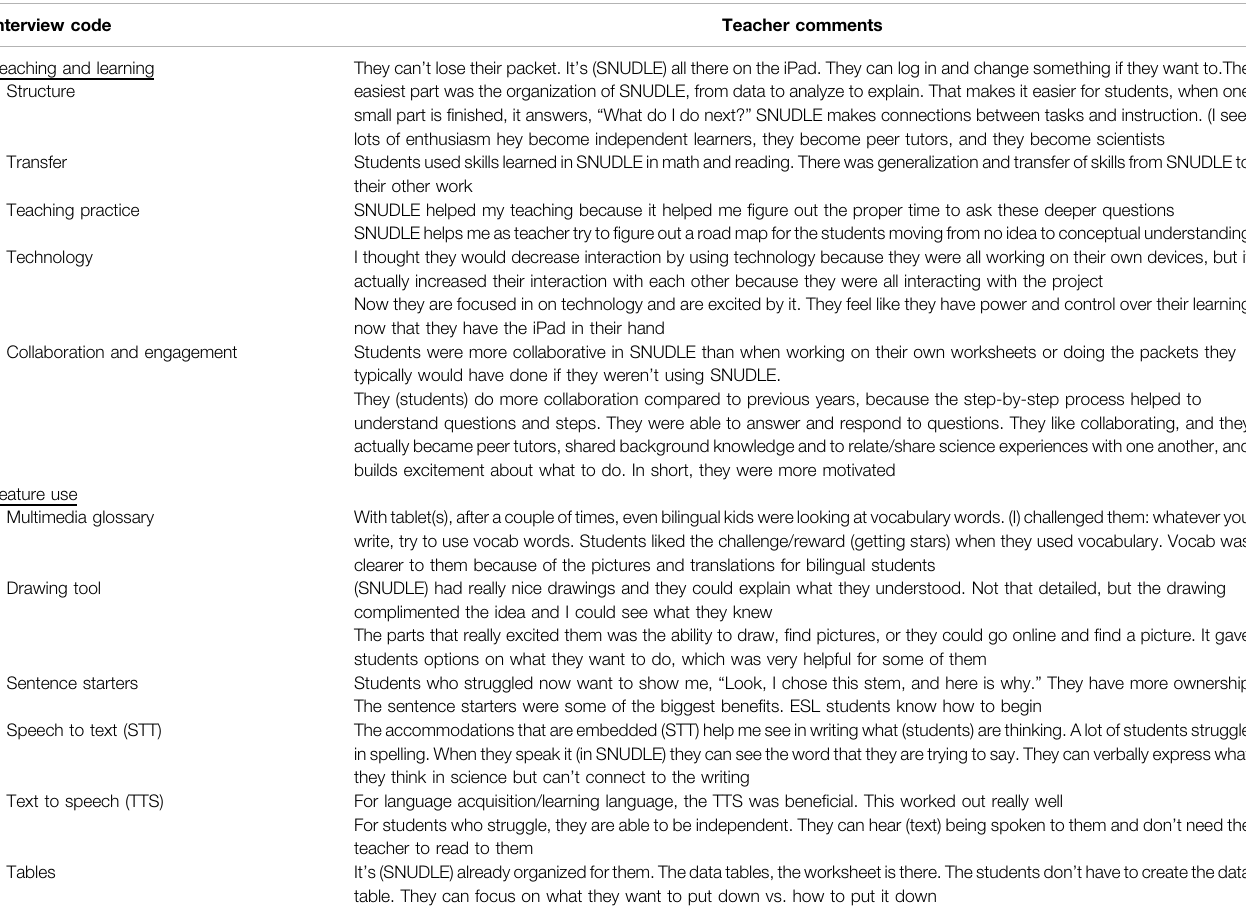
TABLE 7 | Teacher Interview Comments Regarding Use of SNUDLE.